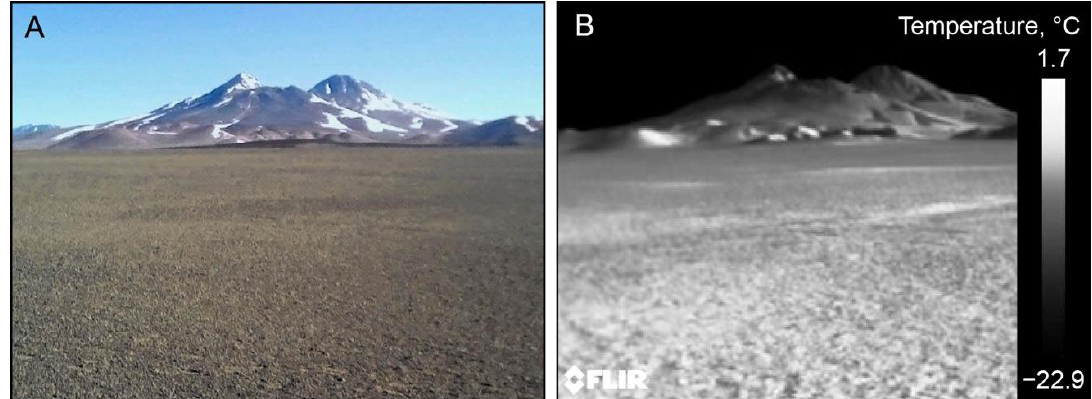
Figure 9. Validation Site #2 (26.9586 ◦ S and 68.8190 ◦ W, 4415 m asl) looking east over on a flat homogeneous alluviated plain. (A) View from the ground; (B) FLIR thermal-infrared image taken from the same spot and view angle. The images are about 6 km across at the foot of the mountain. The resolution of the FLIR image ranges from ~2 cm pixel −1 in the foreground to ~15 m pixel −1 at the foot of the mountain, ~12 km away.